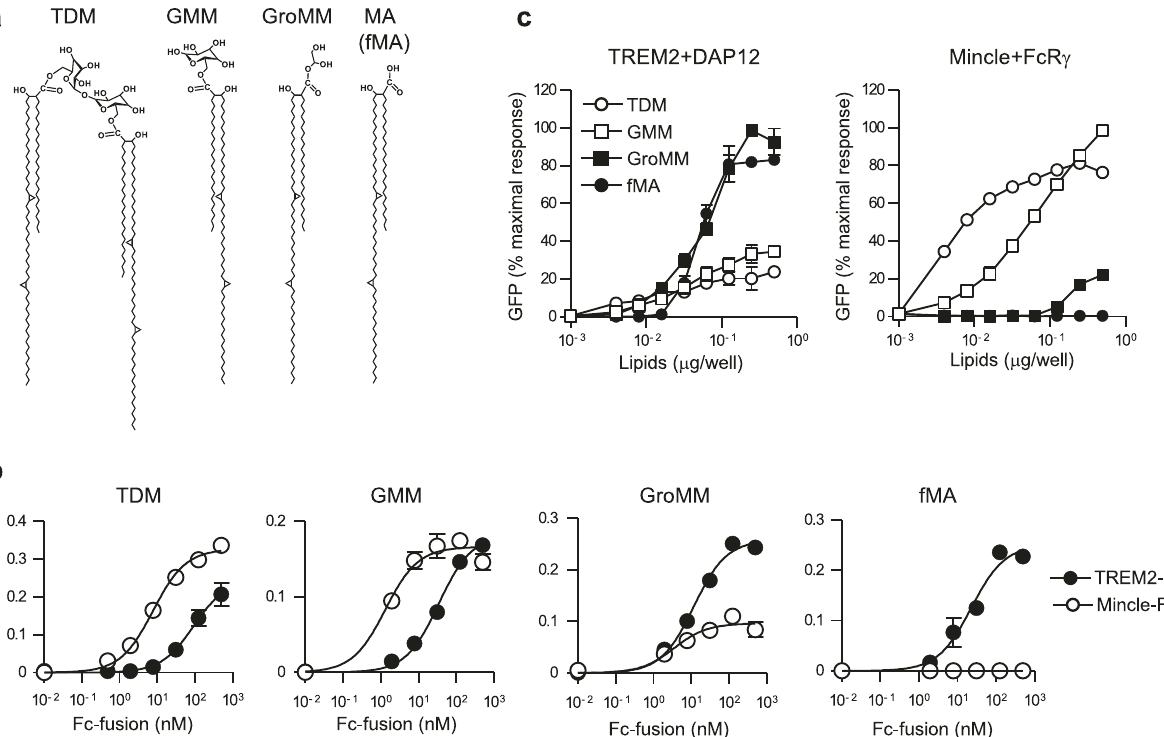
Fig. 3 TREM2 and Mincle preferentially recognize distinct MA-containing lipids based on their glycosylation. a Chemical structure of glycosylated (TDM and GMM) and non-glycosylated (GroMM and fMA) MA-containing lipids found in Mtb. The structures of α -mycolate-containing lipids are included. b The indicated amounts of TREM2 or Mincle-Fc fusion proteins were added to wells coated with 0.5 μ g/well TDM, GMM, GroMM, or fMA, followed by incubation with anti-human IgG-horseradish peroxidase and detection of bound proteins using an enzyme-linked immunosorbent assay (ELISA)-based colorimetric assay. c NFAT-GFP reporter cells expressing TREM2 + DAP12 or Mincle + FcR γ were stimulated with the indicated amounts of TDM, GMM, GroMM, or fMA coated on the plates for 24 h, followed by analysis of GFP fl uorescence by fl ow cytometry. Values are plotted as percent maximal response of the largest value. Data are presented as mean ± SEM of duplicate assays and are representative of at least three independent experiments. Source data are provided as a Source data fi